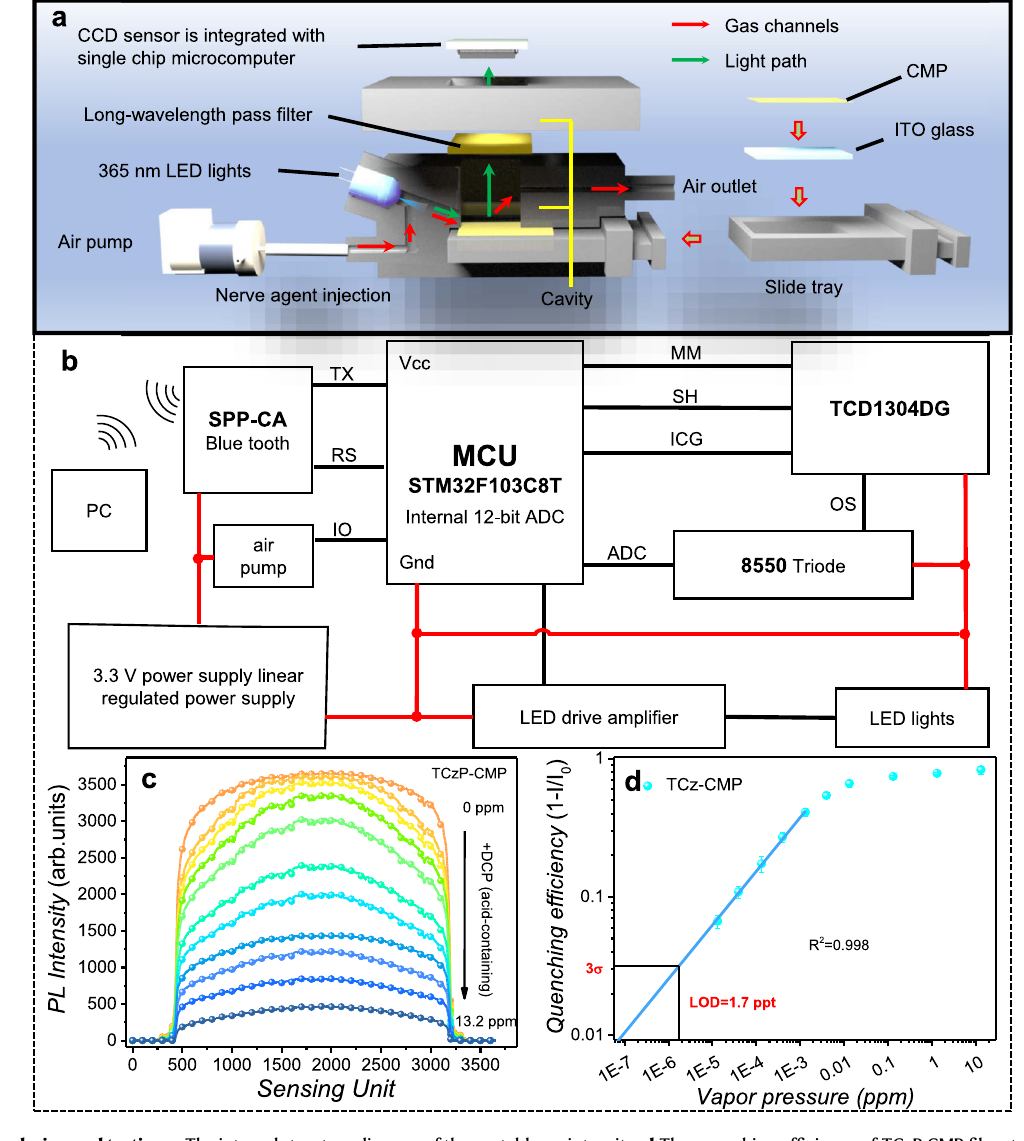
intensity. d The quenching ef fi ciency of TCzP-CMP fi lms to DCP vapors (acid-con- taining) in the portable detection system (the data output are obtained after the integralareaisnormalizedbytheinstrument),3 σ isthreetimesstandarddeviation. Among them, the thickness of TCzP-CMP fi lms is